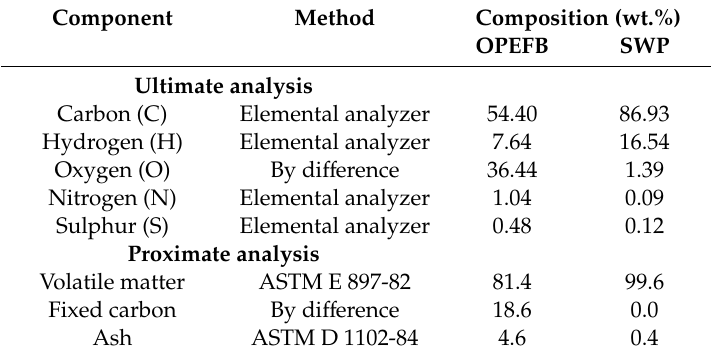
Table 1. Ultimate and proximate composition of